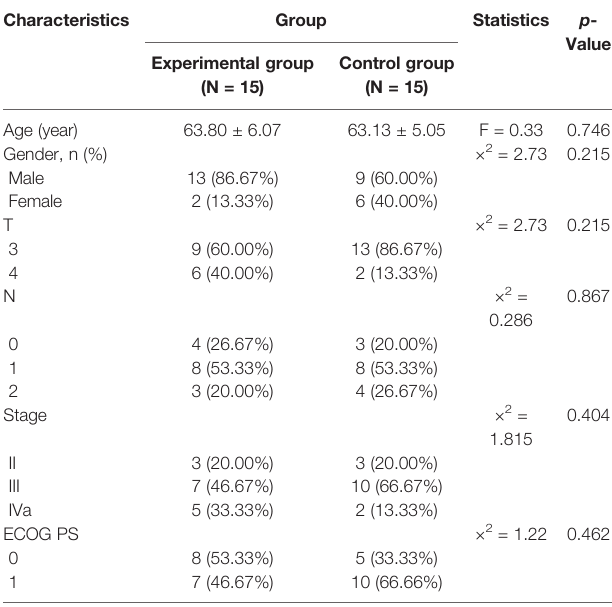
TABLE 1 | Baseline characteristics of different